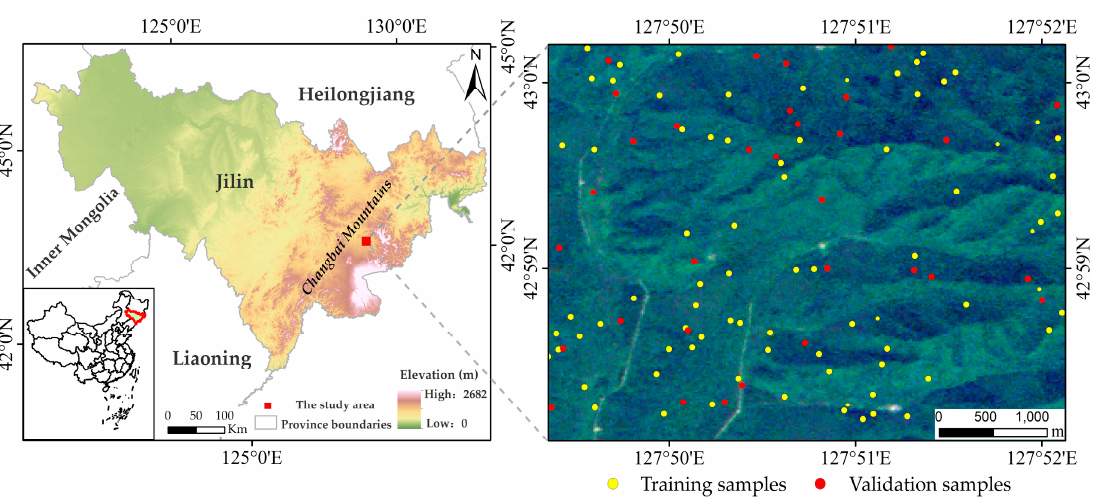
Figure 1. The location of the study site in the Changbai Mountain, the RGB composition (670 nm, 566 nm, and 480 nm) of the hyperspectral image, and the distribution of the samples data.